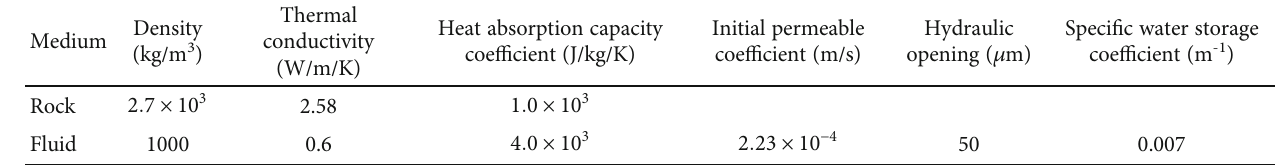
Table 1: Basic parameters of the fl uid-thermal coupling numerical model.